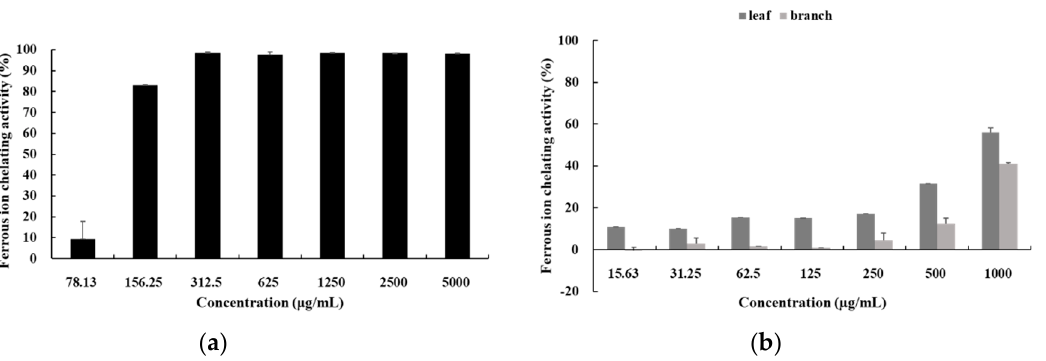
Figure 5. Fe 2+ ion chelating activities of ( a ) EDTA and ( b ) hot-water extracts from S. samarangense . An appropriate amount of EDTA was used as a positive control. The results were expressed as the mean ± SD of data obtained from three independent experiments.